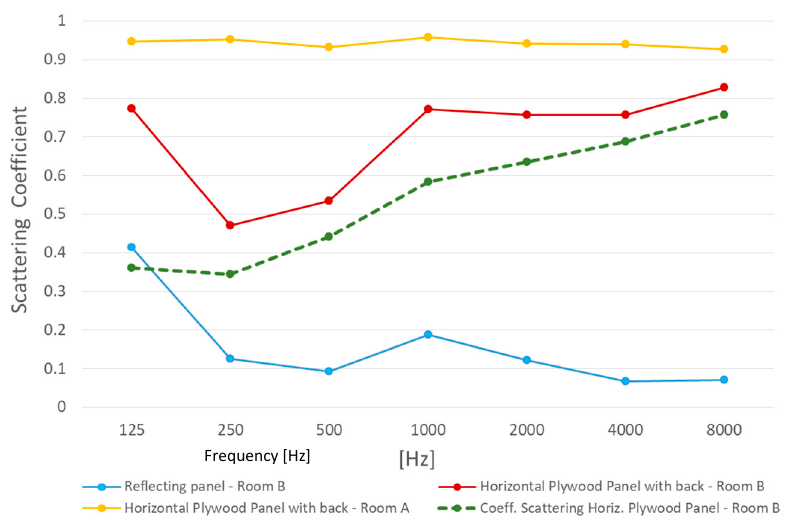
Figure 14. Comparison of the scattering coefficient based on measurements undertaken inside Room A and B (“Coeff. Scattering Horizontal Plywood Panel–Room B” = “Horizontal plywood panel with back-room B”–“Refecting panel”).